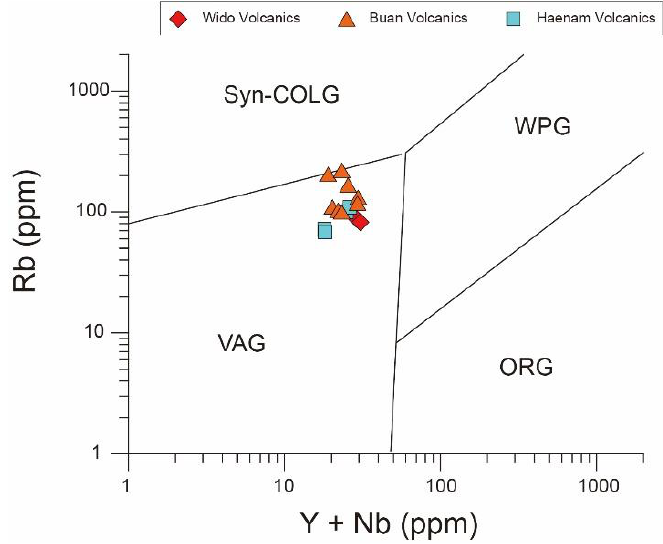
Figure 10. Rb/(Y + Nb) tectonic discrimination diagrams [47]. VAG, volcanic arc granitoids; ORG, ocean ridge granitoids; WPG, within-plate granitoids; syn-COLG and post-COLG, syn- and post- collision granitoids; late and post-COLG, late- and post-collision granitoids.